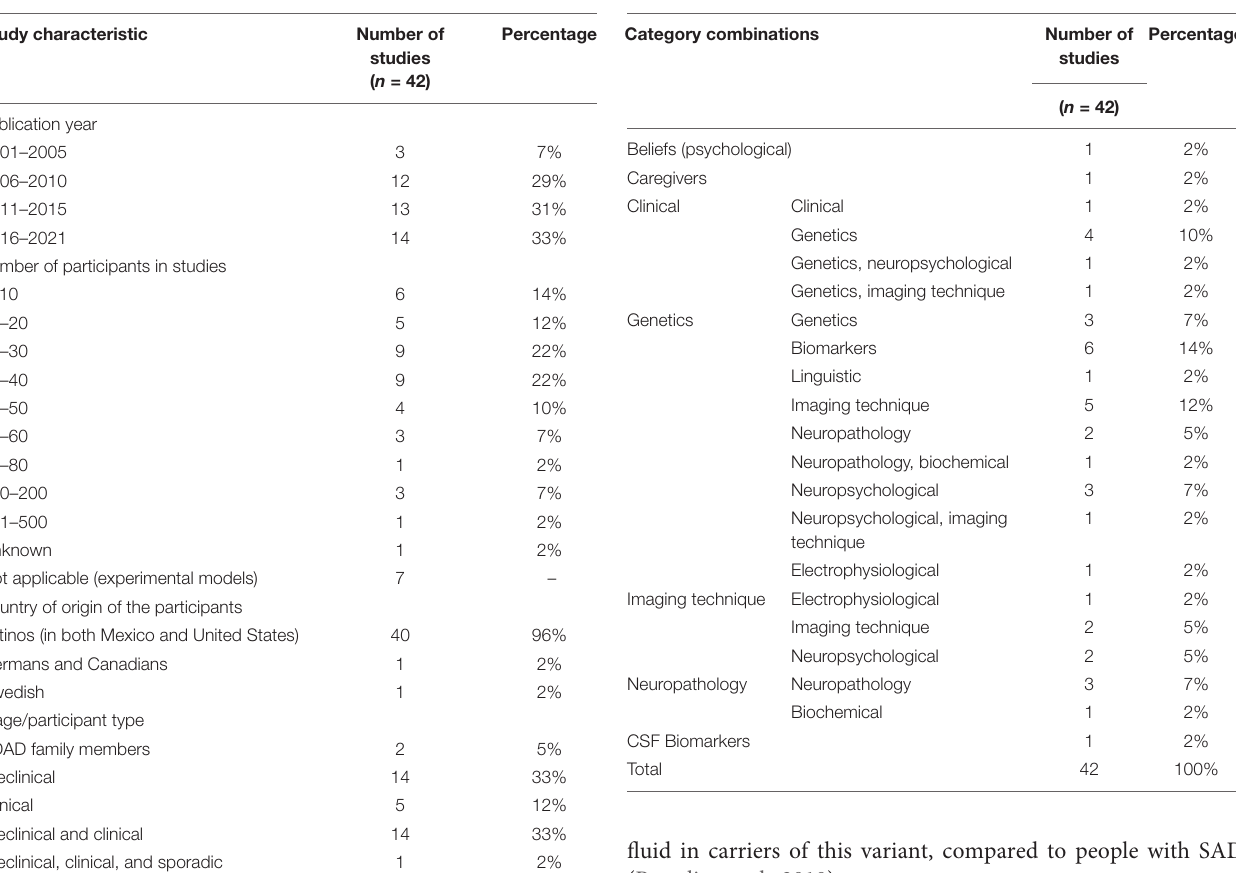
TABLE 1 | Summary of general study